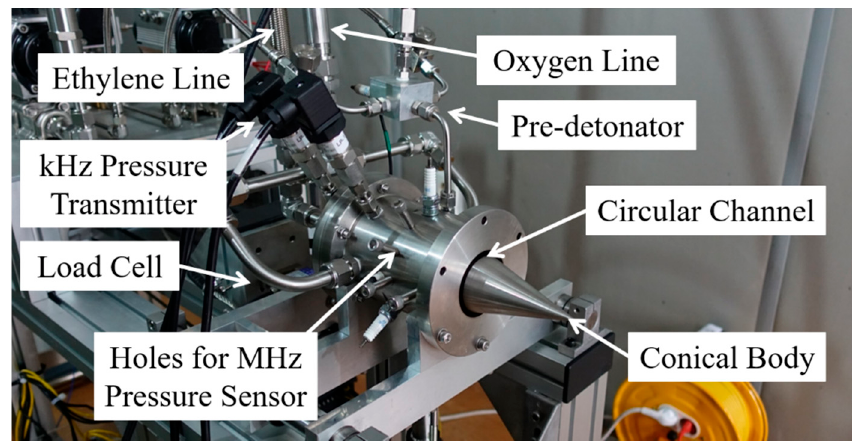
Figure 3. Experimental setup.